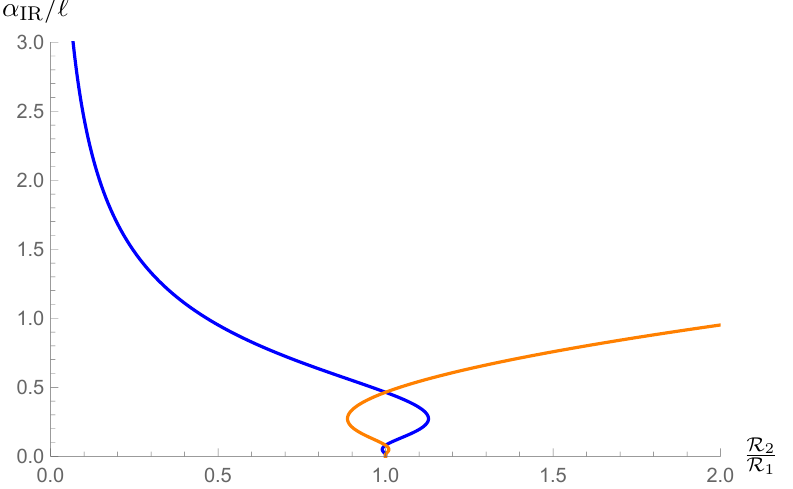
Figure 10 . The IR endpoint radius (cid:11) IR of the sphere which stays (cid:12)nite at the end-point of the (cid:13)ow, as a function of the curvature ratio R 2 = R 1 . The blue curve corresponds to (cid:11) IR where sphere 1 shrinks to zero size in the IR; the yellow curve to (cid:11) IR sphere 2 shrinks to zero. The transition which exchanges the two spheres corresponds to the point where the curves cross at the largest value for the